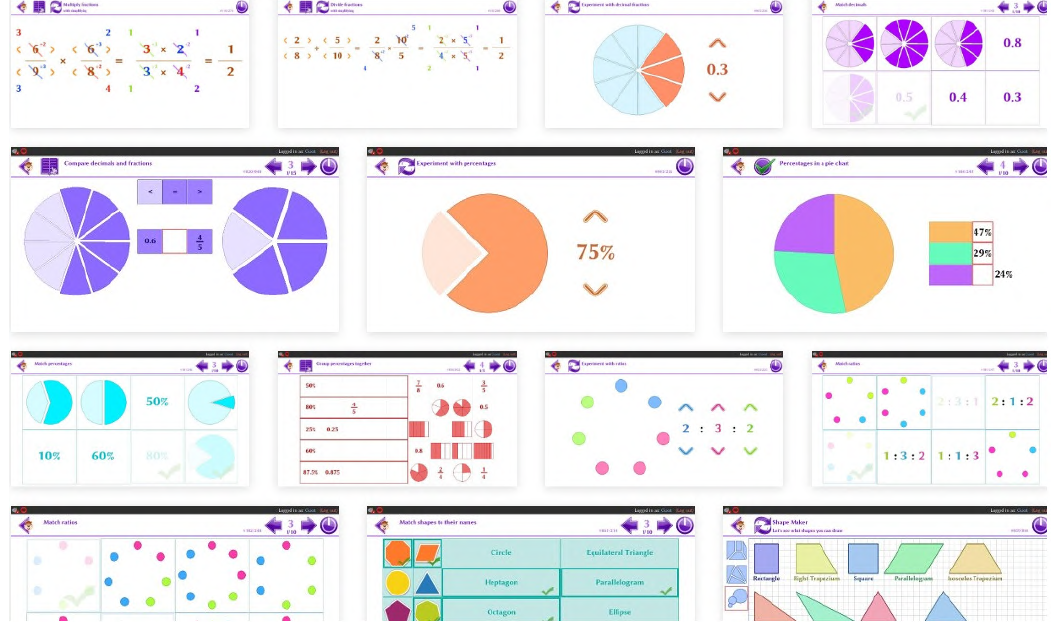
Figure 39: Presentation of paper